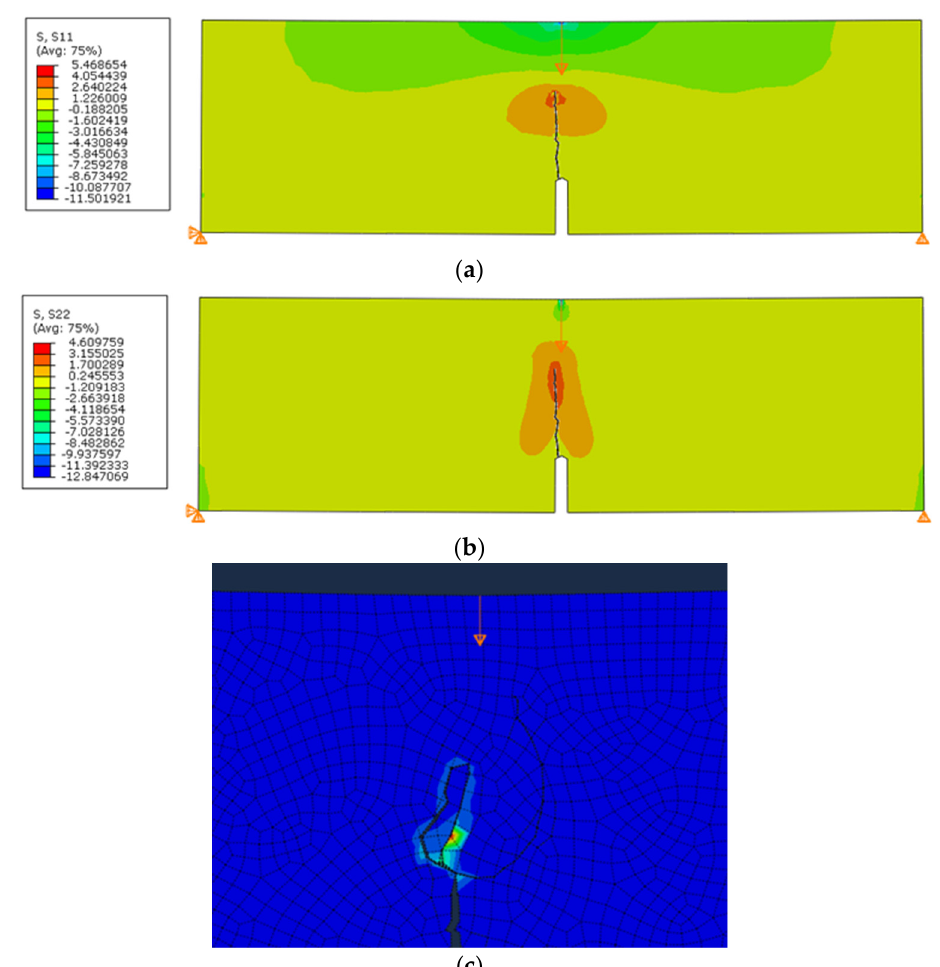
Figure 12. Simulation results for a three-point bending of a notched beam: ( a ) σ 11 ; ( b ) σ 22 ; ( c ) crack curling effect.